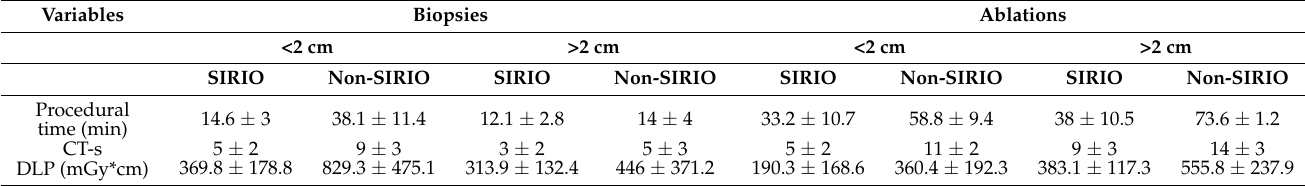
Table 3. Mean values and standard deviations of each variable for all the